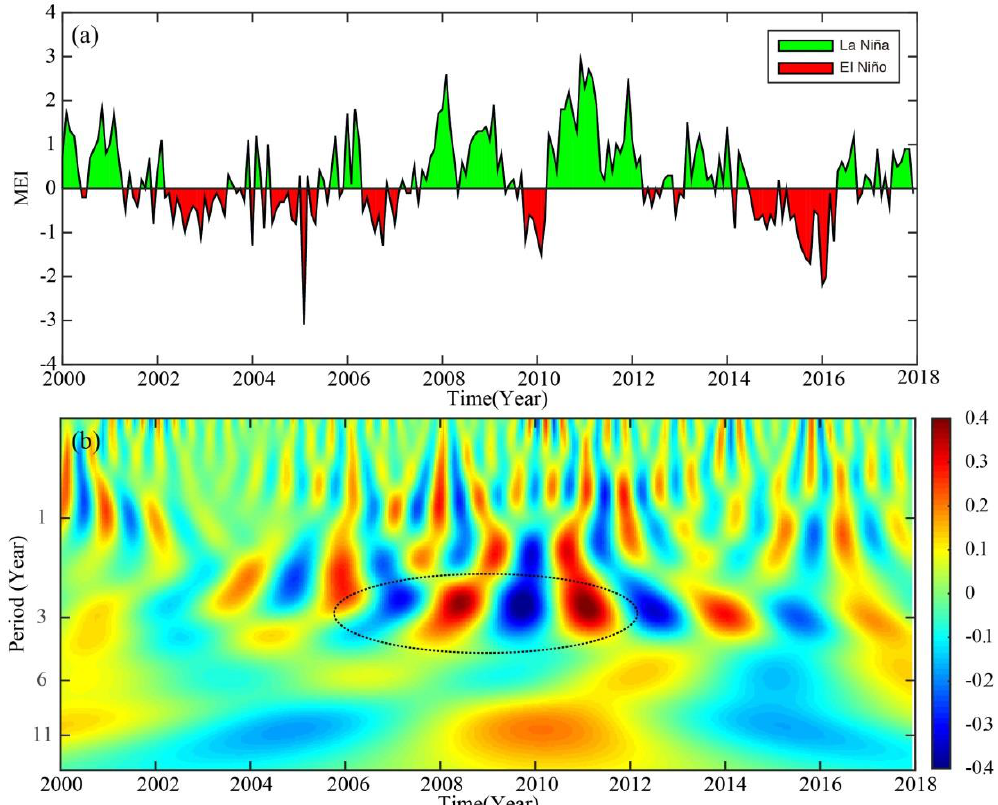
Figure 11. ( a ) Southern Oscillation Index (SOI) during the period from 2000 to 2018. Prolonged periods of positive (negative) SOI values coincide with La Niña (El Niño) episodes. ( b ) Corresponding wavelet time–frequency spectra of the SOI.